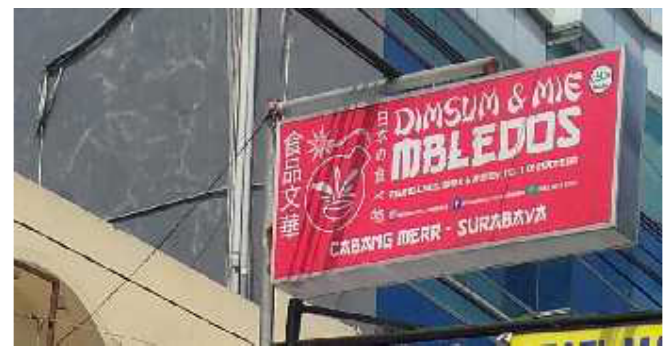
Figure 15. Dimsum & Mie Mbledos